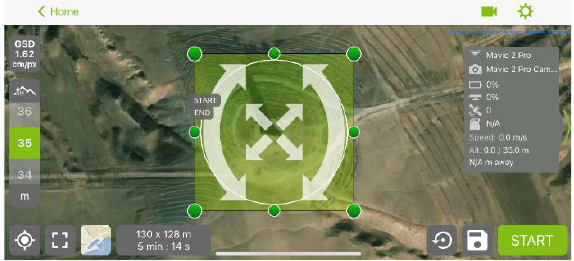
Figure 7. the Circular flight